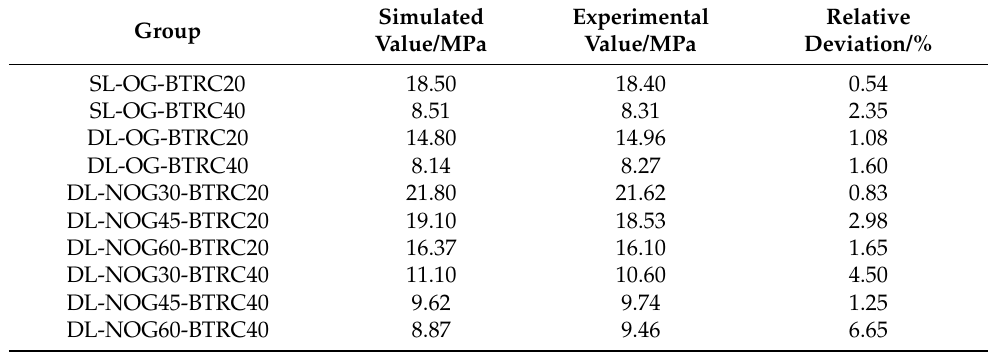
DL-NOG60-BTRC20 16.37 DL-NOG30-BTRC40